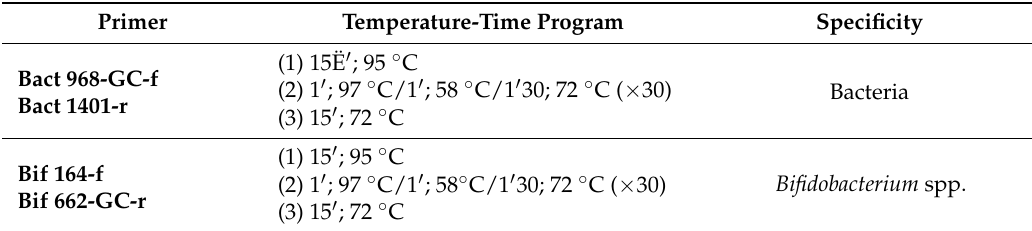
Table 3. Primers and temperature-time programs used in the Polymerase Chain Reaction (PCR) amplification for Temporal Temperature Gradient Gel Electrophoresis (TTGE) diversity